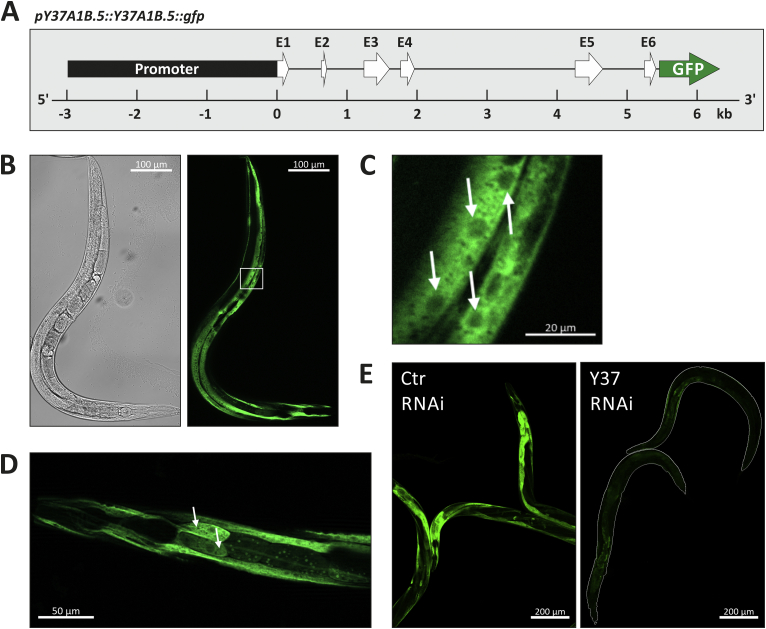
Y37A1B.5 is a cytoplasmic protein expressed in hypodermal cells. (A) Schematic representation of the translational reporter construct used in this study, pY37A1B.5::Y37A1B.5::gfp. (E1-E6, exons 1-6) (B) Hypodermal localization of Y37A1B.5::GFP. White box indicates region enlarged for (C). (C) Subcellularly, Y37A1B.5::GFP is localized primarily in the cytoplasm. White arrows indicate nuclei devoid of signal. (D) Few worms display fluorescence in anterior (arrows) or posterior (not shown) intestinal cells. (E) Comparison of RNAi using control (Ctr) or Y37A1B.5-specific (Y37) plasmids on Y37A1B.5::GFP reporter strain. White lines indicate worm shape.